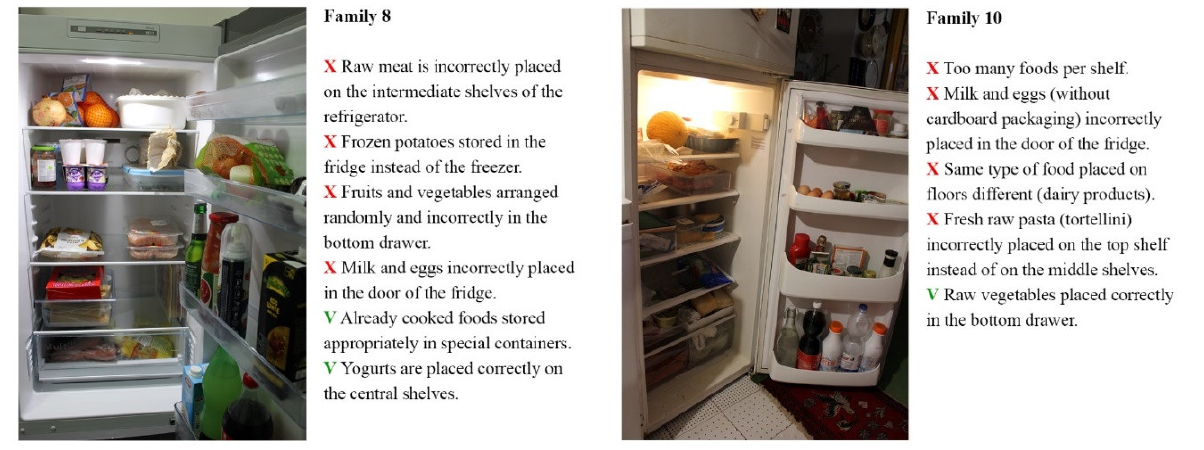
Figure 5. Evaluation of refrigerators.